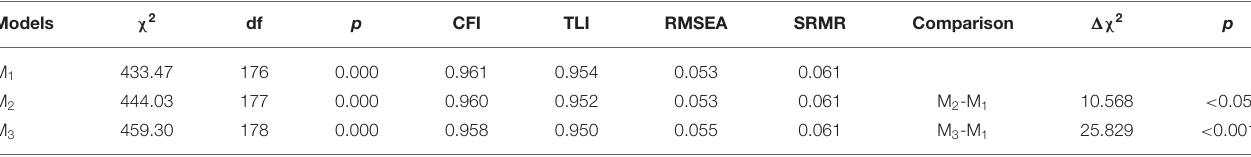
TABLE 3 | Results of alternative Structural Equation Models (SEMs).